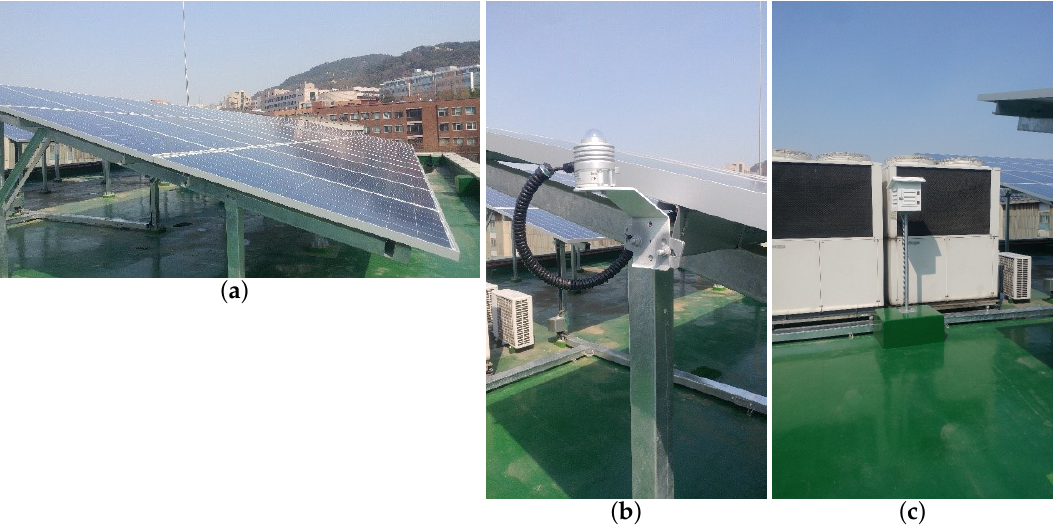
Figure 1. Our solar power system installation site used for the experiments in this paper. ( a ) solar panels (Amorphous Silicon); ( b ) solar irradiance sensor installed near the solar panels; ( c ) temperature and humidity sensors in the white-painted instrument